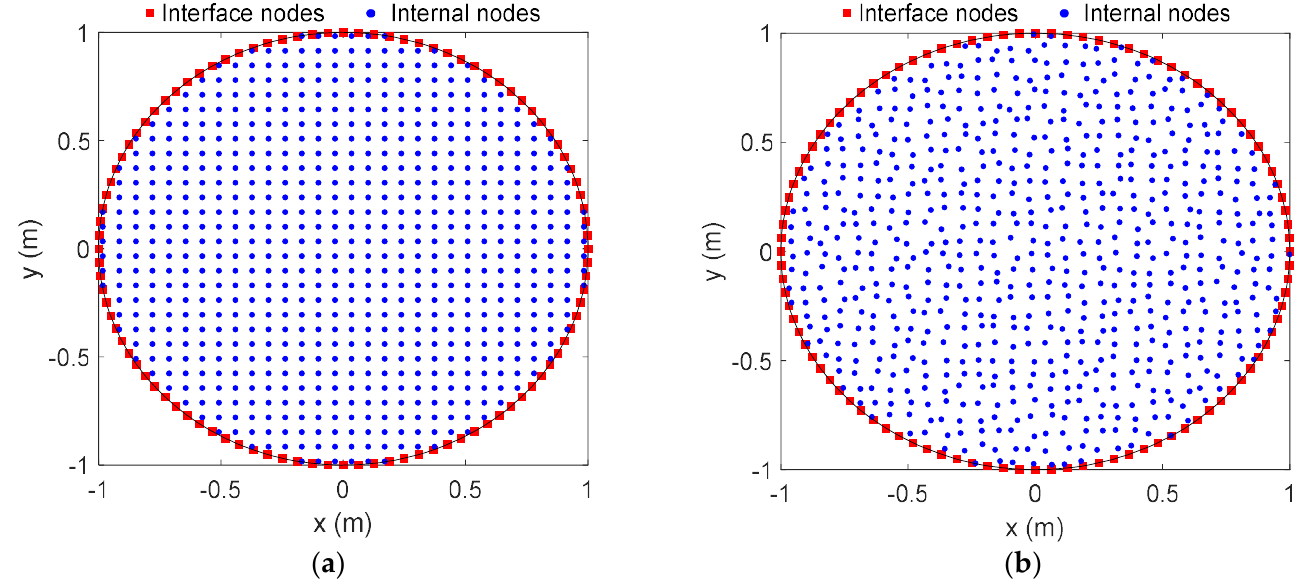
Figure 6. Nodal distributions: ( a ) regular nodes and ( b ) irregular nodes. Figure 7 displays the profiles of the analytical response in the domain [ − 2, 2 ] × [ − 2, 2 ] , and Figures 8 and 9 depict the absolute errors of the proposed method under regular and irregular nodes, respectively. It was noted that the numerical solutions are in good agreement with the analytical one for the regular and irregular distributions of nodes, and the numerical errors are small. In this example, the condition number of the proposed approach is 4.665 × 10 11 .